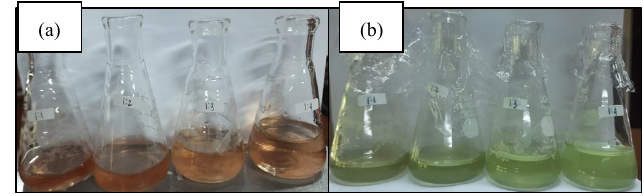
Fig. 1. The synthesized results (a) after 1 minute and (b) after 3 hours